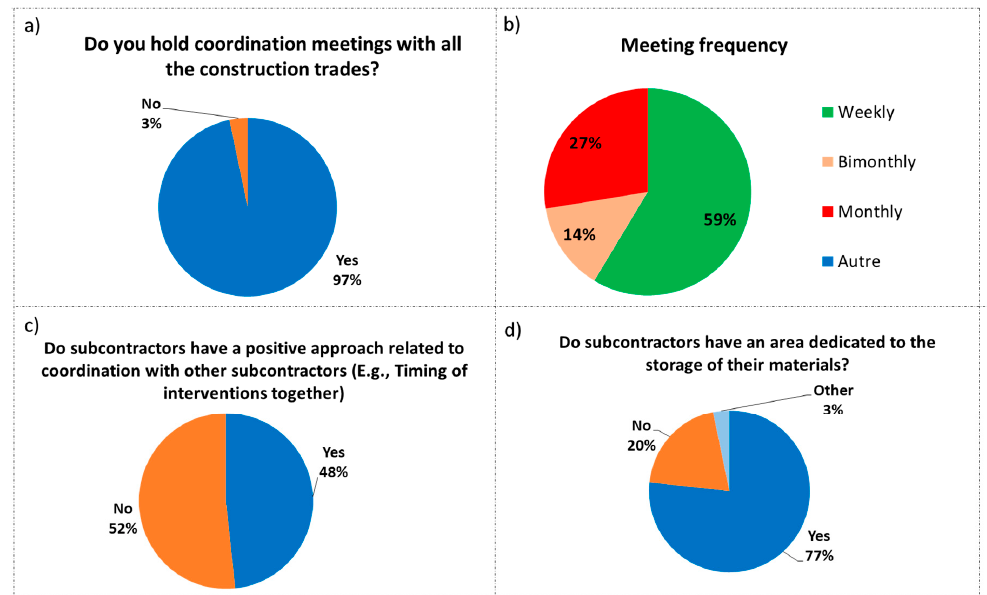
Figure 10. Questions for contractors related to subcontractors’ coordination.